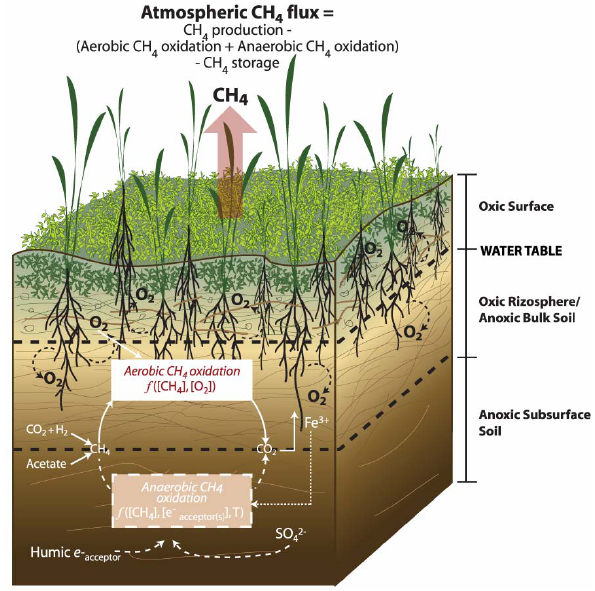
Fig. 1. Conceptual model of CH 4 cycling in the profile of Sphag- num sp. and Carex sp. covered peat-forming wetland that depicts the relationship between water table depth, plant rooting zone, and redox status. Solid boxes and arrows represent known processes and controls on CH 4 flux, dashed black arrows represent O 2 flux from plant roots, and dashed white boxes and arrows represent recently quantified or hypothesized processes and controls. The proposed equation at the top illustrates the sum of the processes and factors controlling net atmospheric CH 4 flux rates from wetland ecosys-